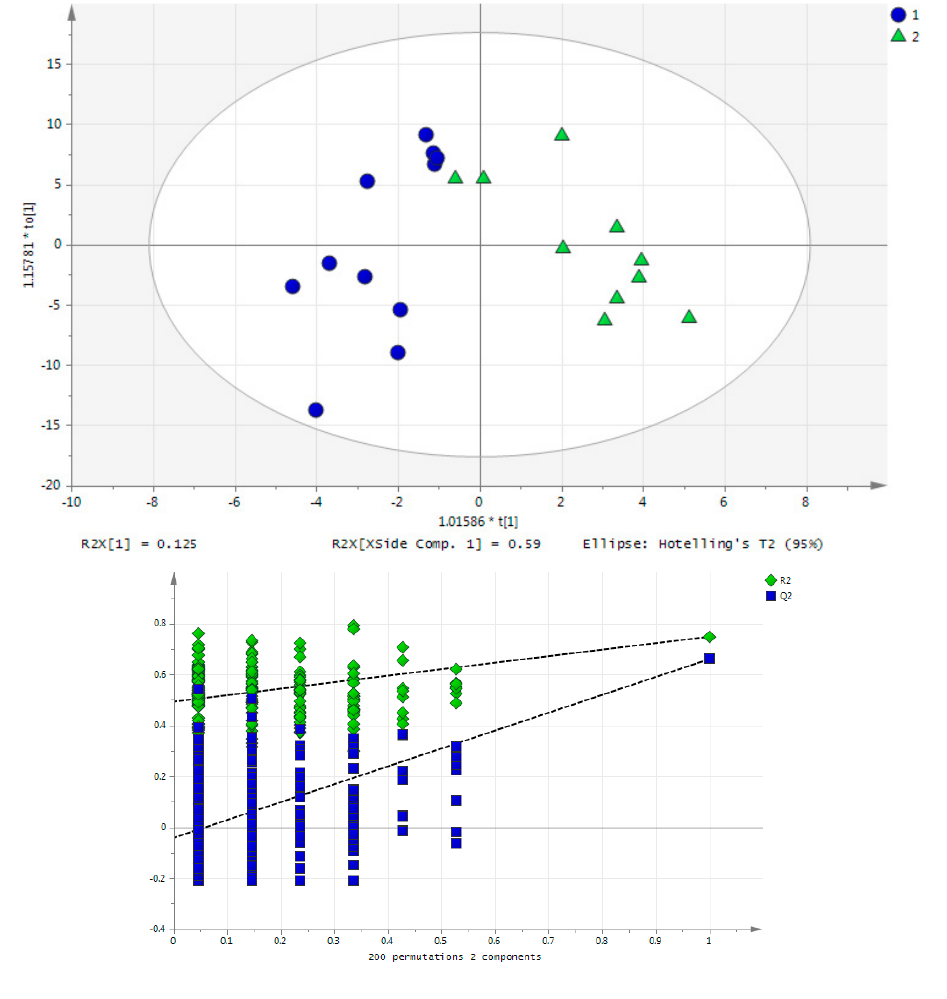
Figure 4. OPLS-DA scores plot of rat urine samples pre- (blue) and post- (green) acute exercise session. The inset permutation plot demonstrates a statistically significantly model.